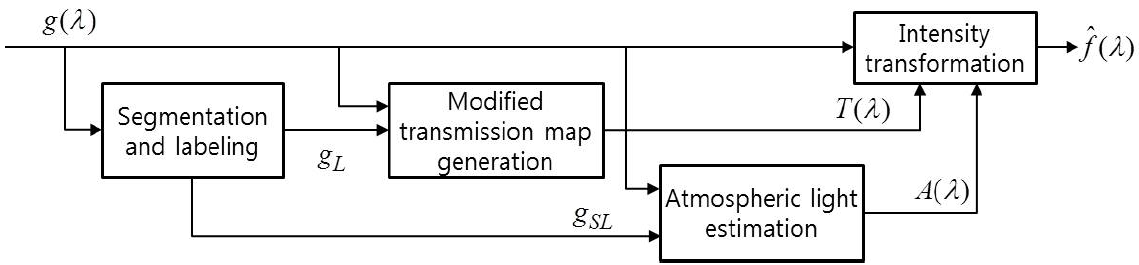
Figure 5. The proposed single UAV image-based dehazing algorithm for enhancing hazy UAV